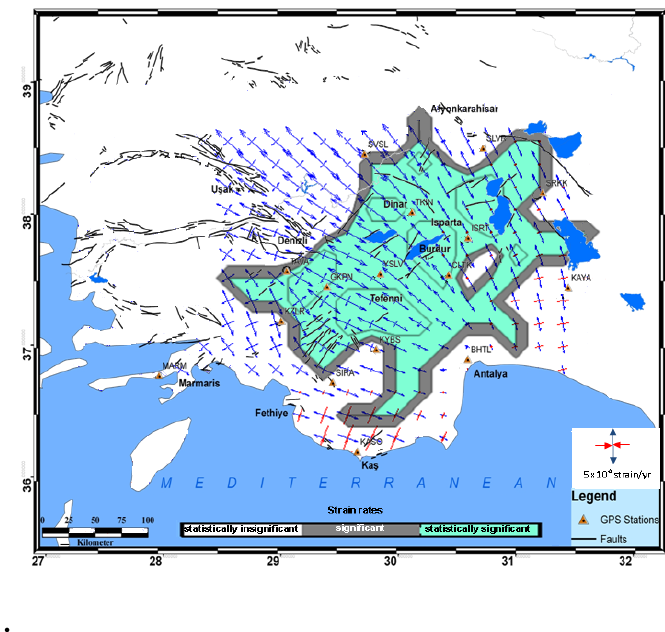
Figure 6. Principal Strain rates. Blue and red arrows show maximum extension and compression, respectively in 10 -7 strain/year.